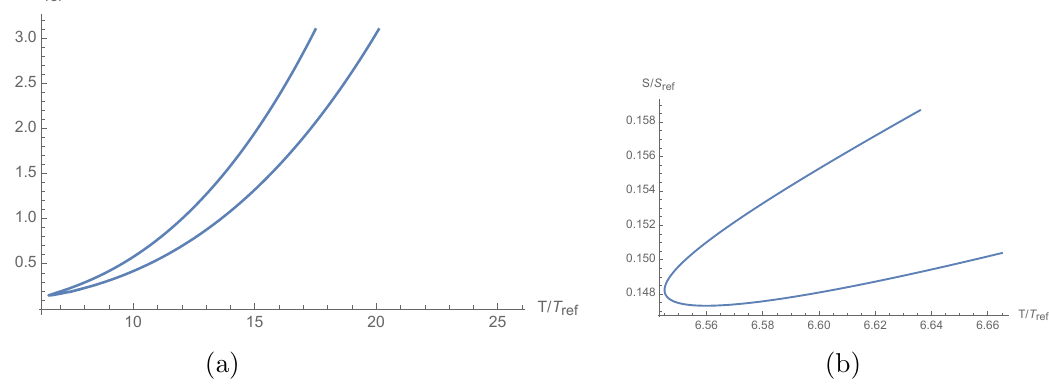
Figure 24 . (a) S as a function of T in region II. (b) Blow up of the (cid:12)gure around the minimum of S .